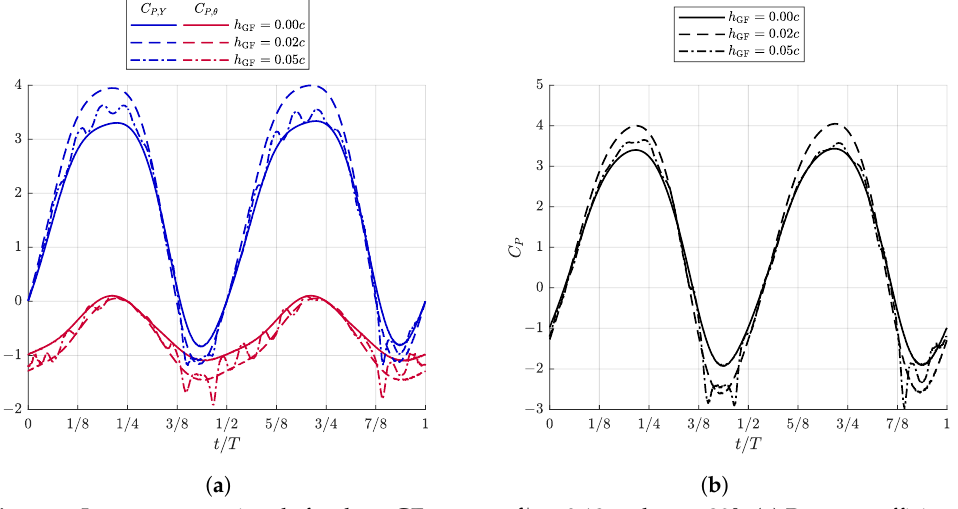
Figure 8. Instantaneous signals for three GF cases at f ∗ = 0.18 and α 0 = 29 ◦ . ( a ) Power coefficients of heave and pitch. ( b ) Total power extraction